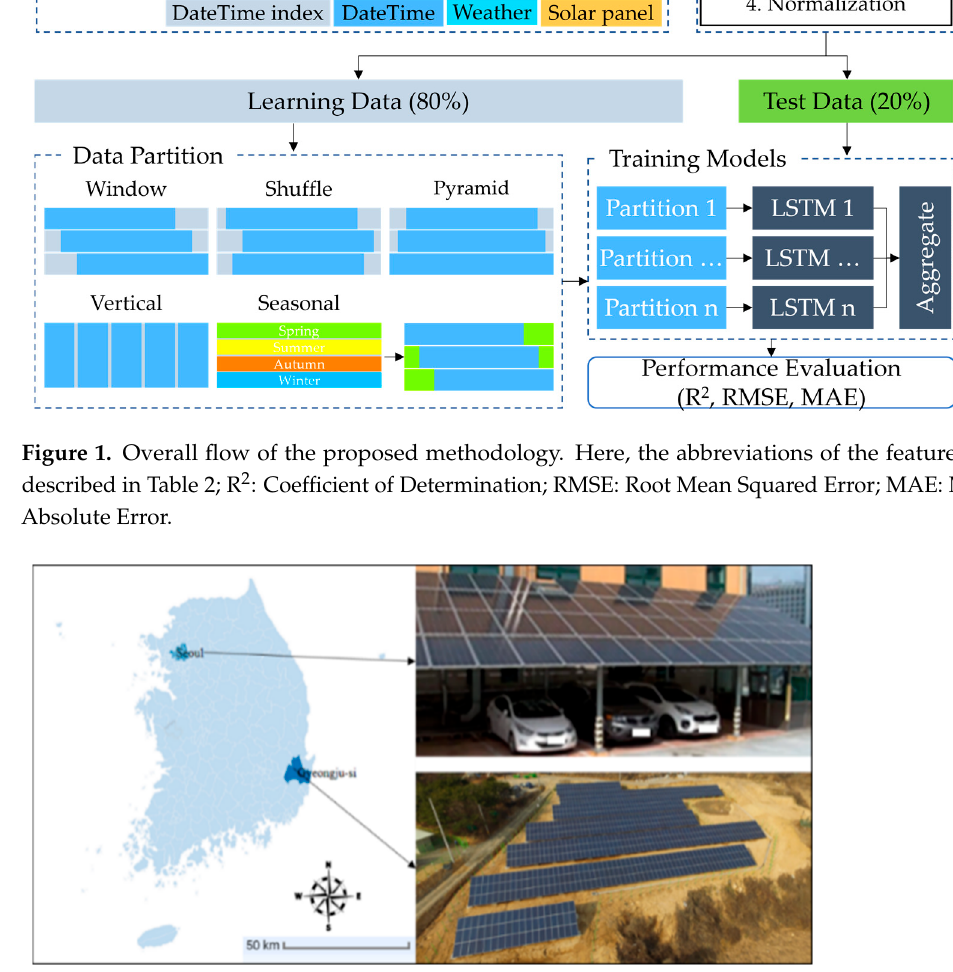
Figure 1. Overall flow of the proposed methodology. Here, the abbreviations of the features are described in Table 2; R 2 : Coefficient of Determination; RMSE: Root Mean Squared Error; MAE: Mean Absolute Error.